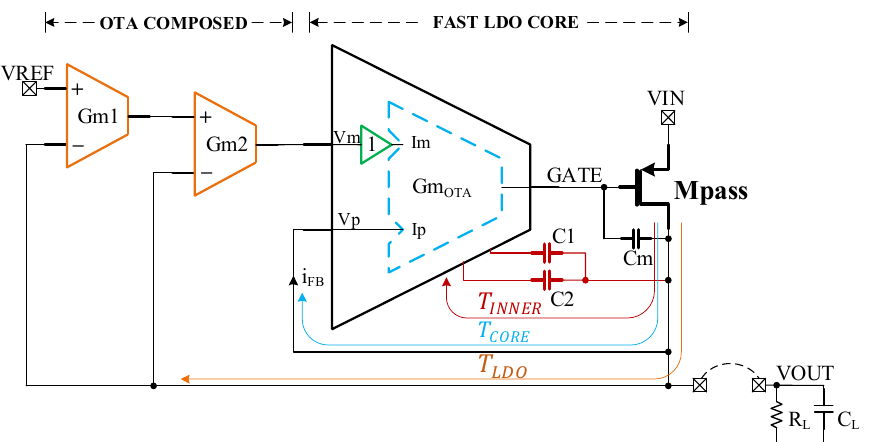
Figure 2. Topology of the proposed LDO: three Gm cells, each of them connected to the LDO output by total negative feedback loops. Each cell can be optimized individually, for different